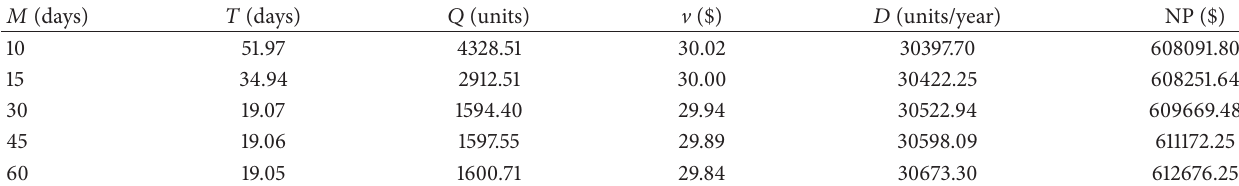
Table 1: The obtained solutions by cuckoo search algorithm for Example 1.